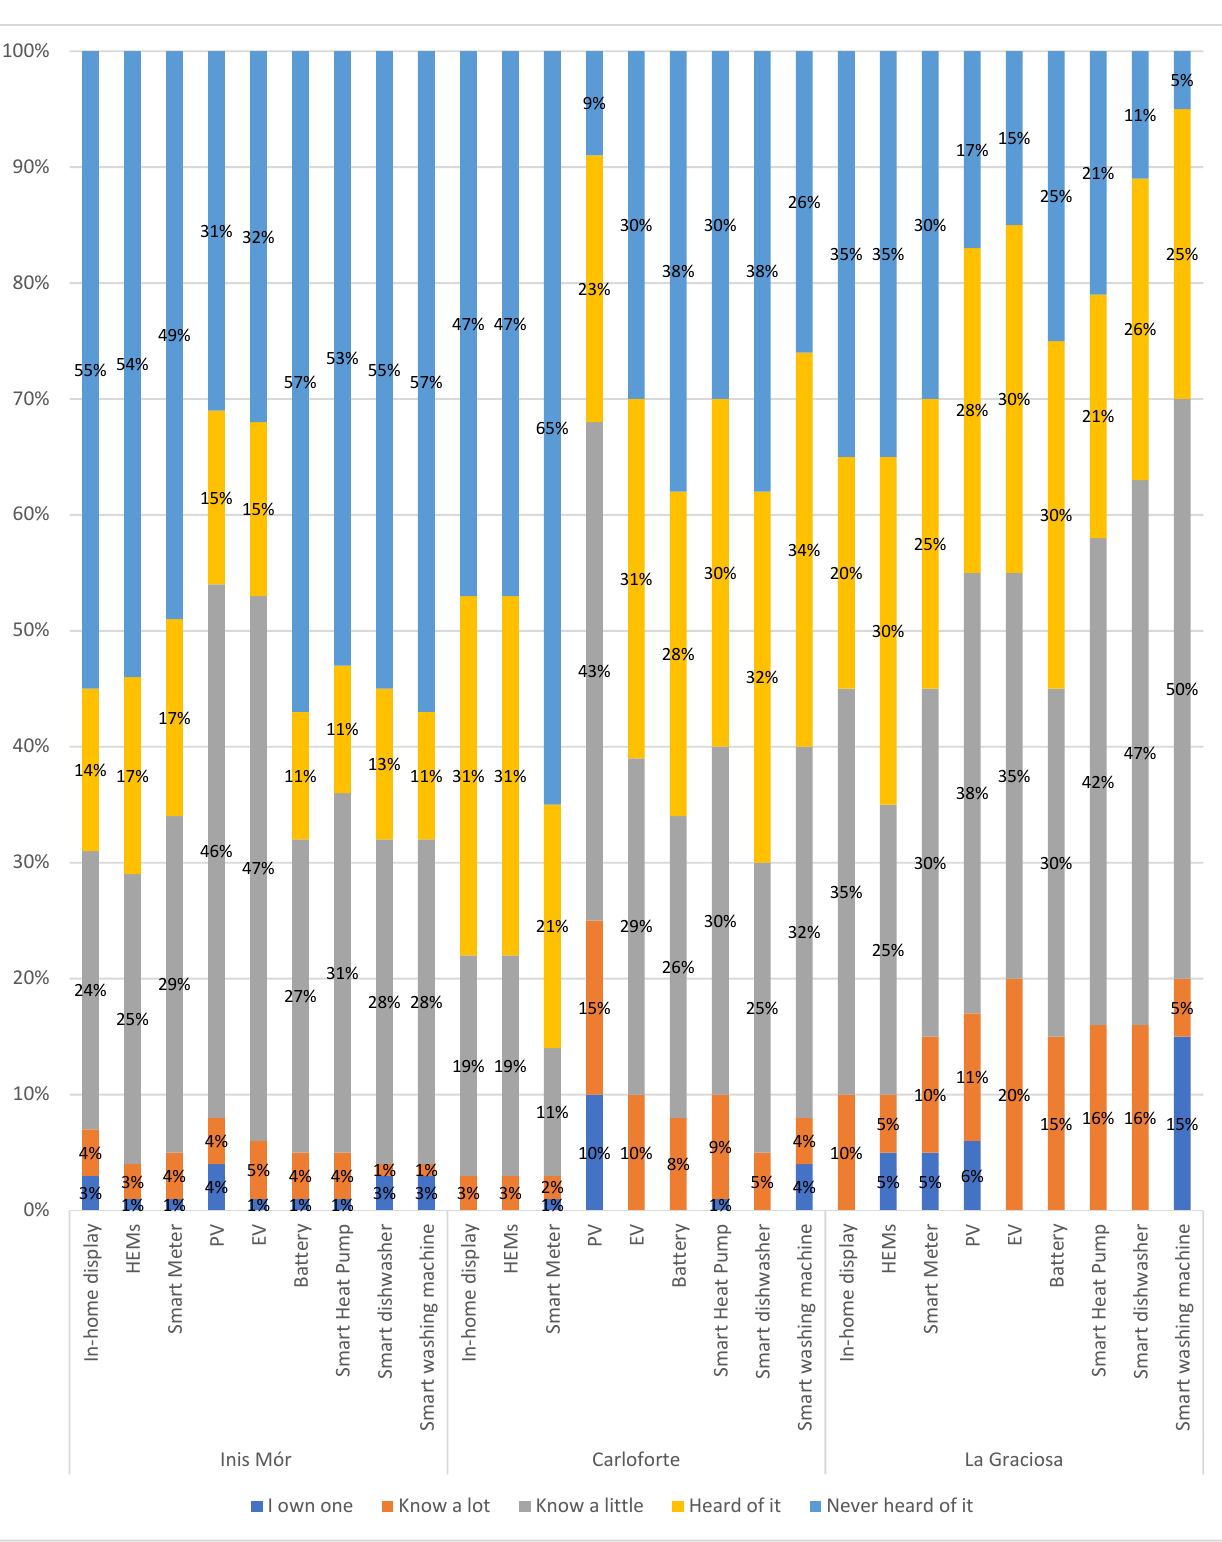
Figure 6. Familiarity of the three island residents with various Smart Grid technologies. Overall, as illustrated in Figure 6, very few of the respondents from all three islands owned or had a significant knowledge of any of the SG and DR enabling technologies.